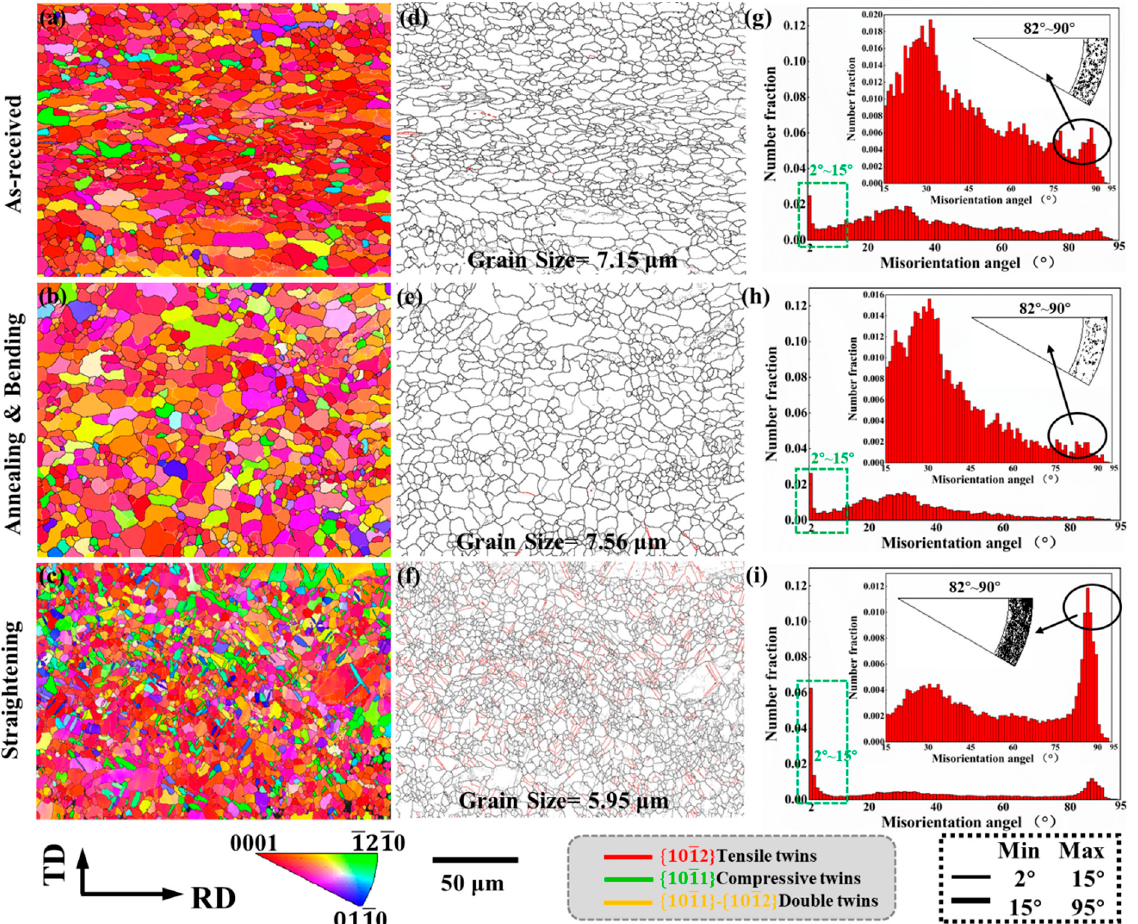
Figure 2. EBSD results: ( a , d , g ) as-received sample, ( b , e , h ) the sample after bending, and ( c , f , i ) the sample after bending and straightening; inserted in the figure is the distribution of misorientation rotation axes in the range of 82°~90°.